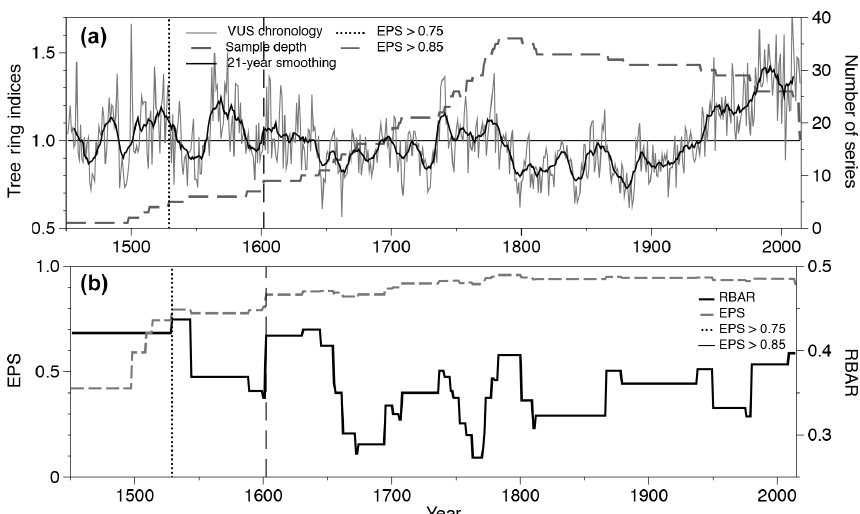
Figure 3. Variations in the VUS chronology and sample depth (a) and the expressed population signal (EPS) and average correlation between all series (Rbar) VUS chronology from AD1451 to 2014 (b) .